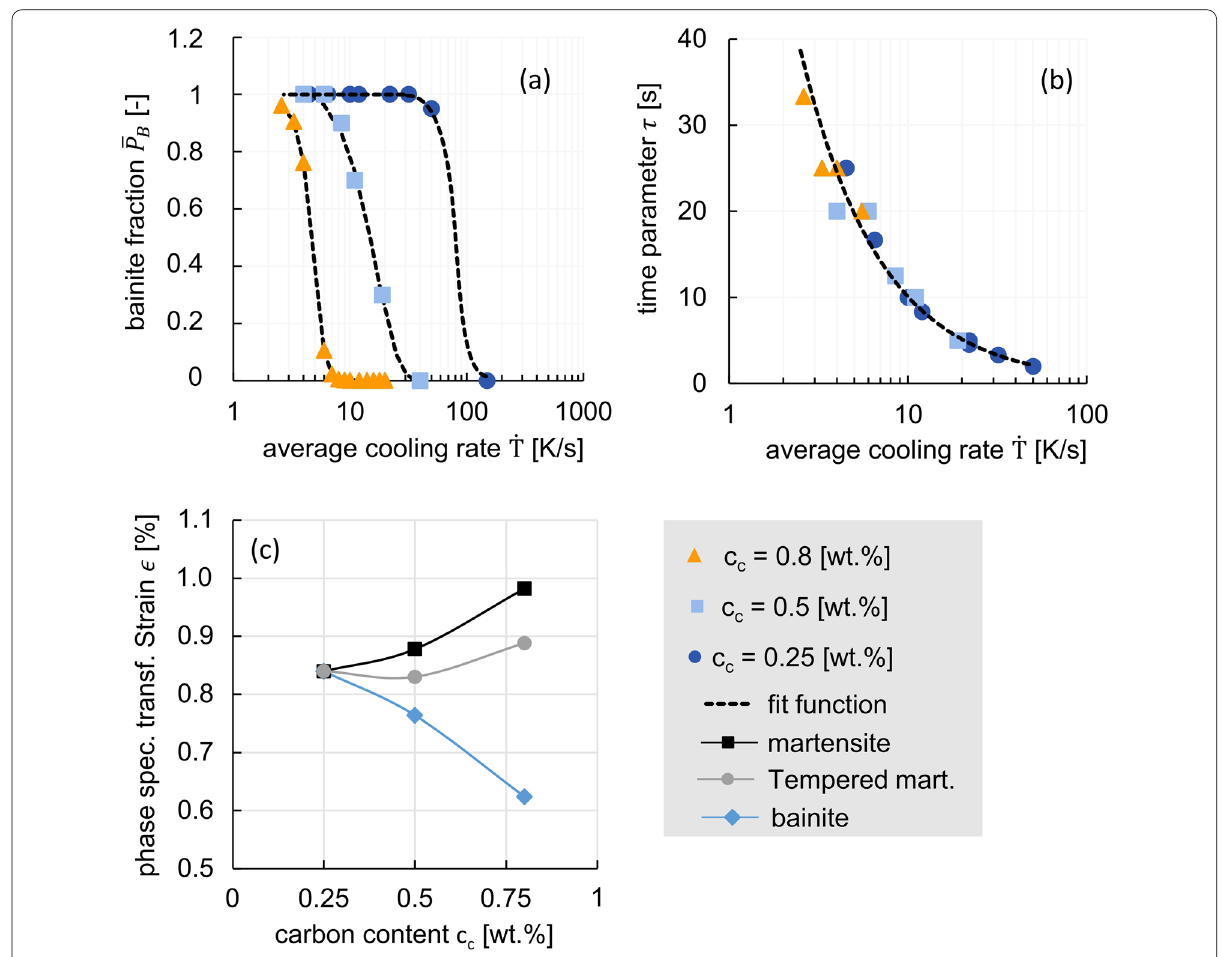
Figure 5 Model parameters for Eqs. (15) and (17): a bainite fraction P B , b Avrami-time parameter τ , c phase specific transformation strain